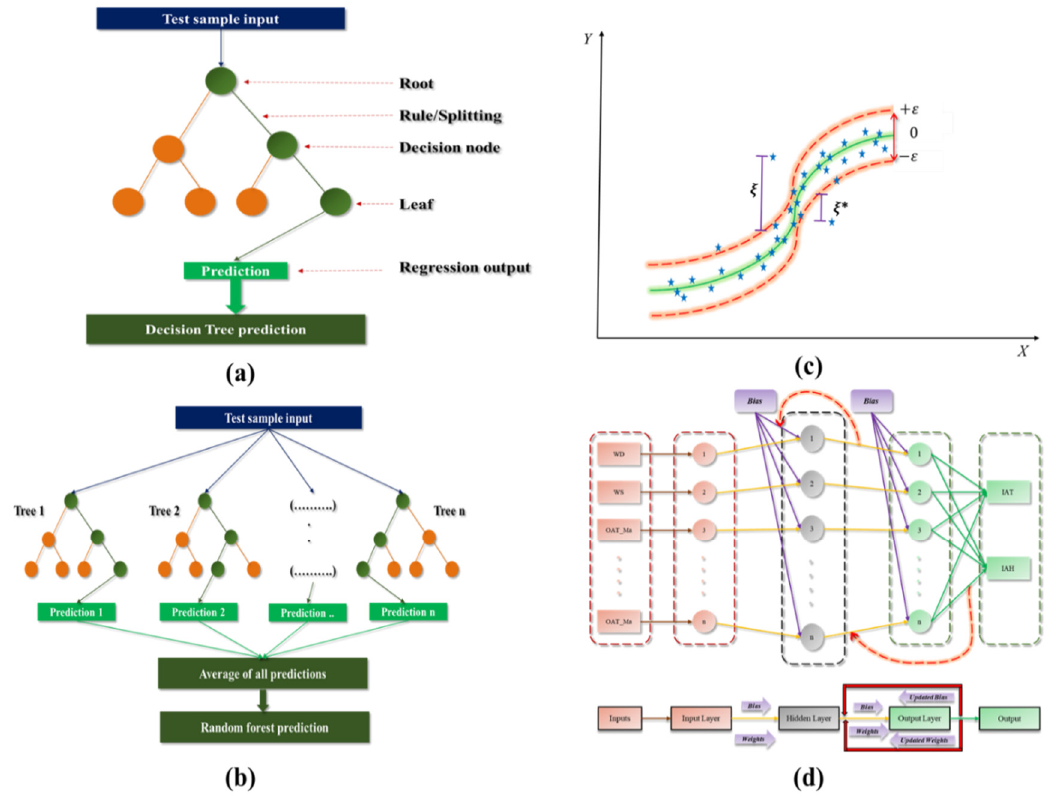
Figure 3. Important parameters and operational blue print of ( a ) Decision tree regression model, ( b ) Random forest regression model, ( c ) Support vector regression model, ( d ) Multilayered perceptron—Back propagation model.